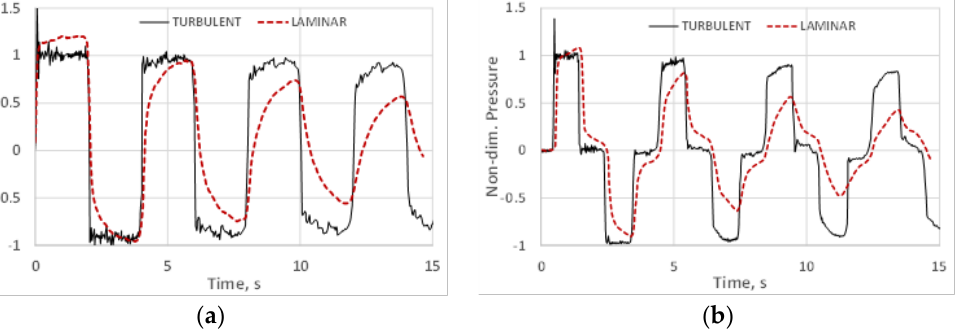
Figure 2. Measured pressures following rapid valve closure in a laboratory pipe (after Holmboe, [6]). ( a ) At the valve. ( b ) At mid-pipe. ( a ) At the valve. ( b ) At